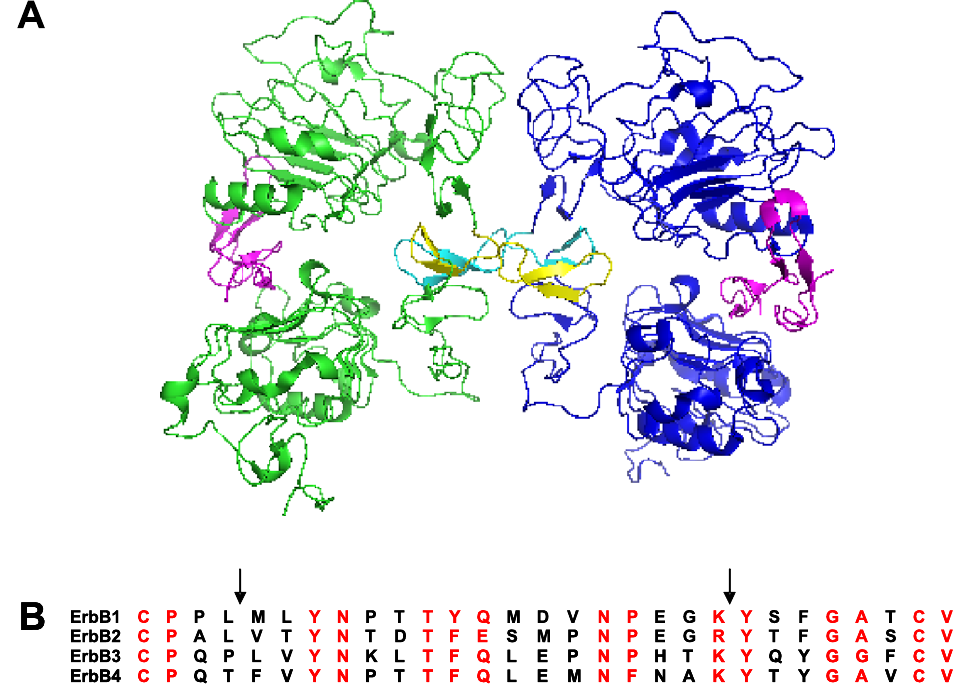
Fig. 1. The ErbB receptor dimerization arm motif. (A) Backbone diagram of the crystal structure of a homodimer of the first three extracellular domains of two human ErbB1 molecules (shown in green and blue, respectively), each complexed with one EGF molecule (marked in magenta) (PDB no. 1IVO). The “dimerization arms” of both ErbB1 molecules, constituting most of the receptor–receptor interaction interface in the structure, are shown in yellow (for the molecule in green) and cyan (for the molecule in blue). (B) Sequence alignment of the fifth disulfide-bonded module (dimerization arm) in the second extracellular domain of ErbB1–4. The N - and C -termini of the Inherbin peptides are marked with arrows. Residues that are identical in at least three ErbB family members are marked in red. (The colors are visible in the online version of the